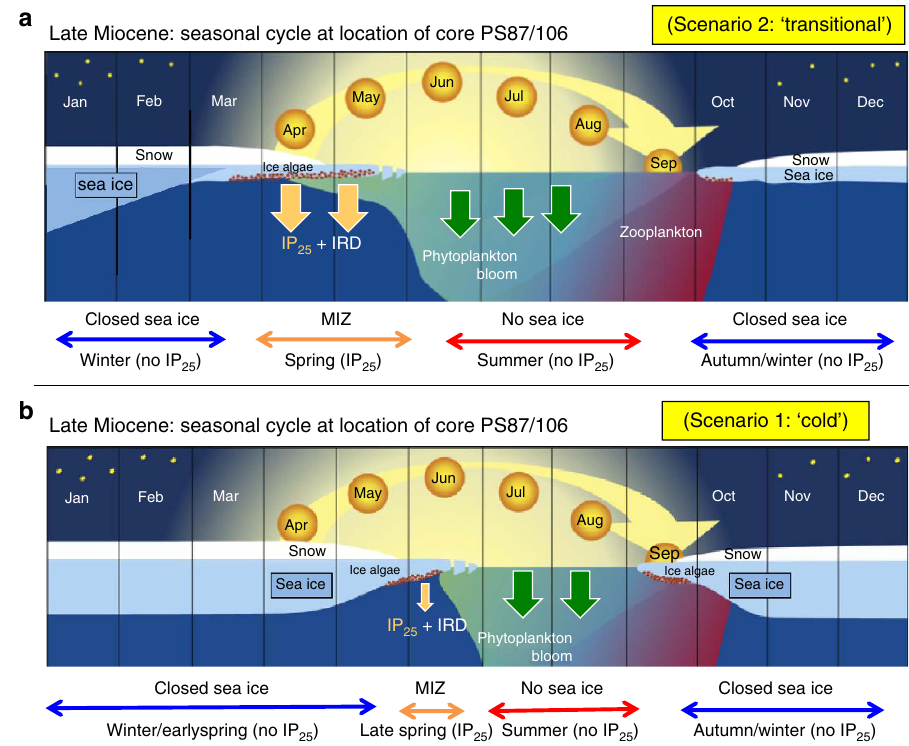
Figure 5 | Schematic illustrations of the seasonal sea-ice cycle during the late Miocene. The seasonal sea-ice cycle and related principal processes controlling productivity and carbon flux at location of central Arctic Ocean Core PS87/106 during the late Miocene are shown for two different scenarios. ( a ) Scenario 2 (‘warmer/transitional situation’) ¼ extended period of spring sea-ice algae productivity and increased IP 25 and phytoplankton biomarker fluxes. ( b ) Scenario 1 (‘cold situation’) ¼ restricted period of late spring sea-ice algae productivity and very reduced fluxes (almost to zero) of IP 25 and spring phytoplankton biomarkers; cf ., Fig. 1). MIZ, Marginal Ice Zone, that is, ice-edge situation. The dark period, height of the sun and changing thickness of snow and ice over the year, as well as phytoplankton, zooplankton and sea-ice productivity are shown. IP 25 values for the different seasons are indicated (after ref. 72,